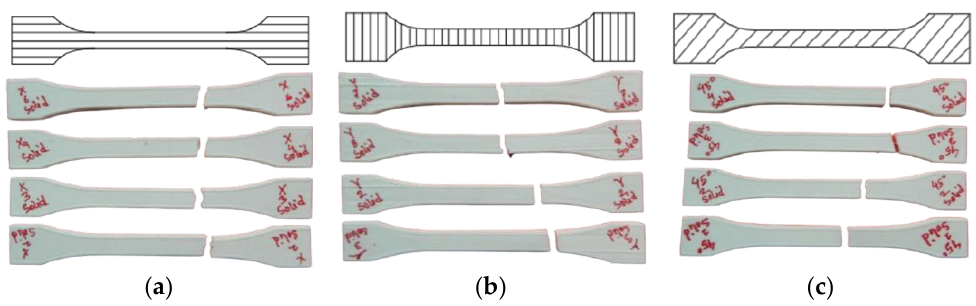
Figure 9. Fatigue failure profile of tensile PLA prints with a raster angle of ( a ) 0°, ( b ) 90°, and ( c ) 45° (Adapted with permission from [37]. Copyright 2015, Springer Nature).